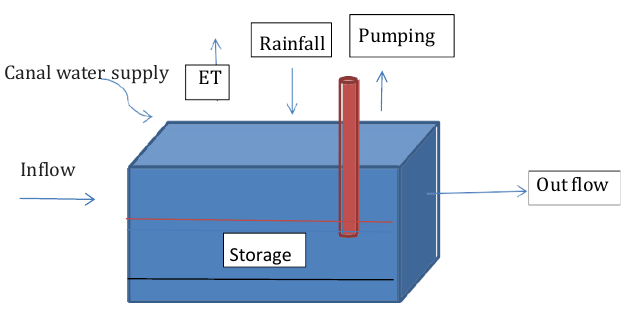
Figure 4: Conceptual Water Balance